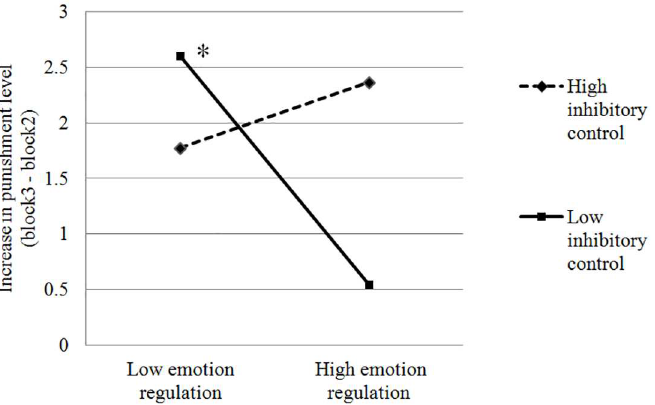
Fig 1. Interactive effect of emotion regulation and inhibitory control on increasein punishment level. a. Predicted values of increase in punishment are plotted 1 standard deviationabove and belowthe mean for NMR [35]. b. The slope for high SSRT (low inhibitorycontrol) is significantly different from zero ( p = .002), and the slope for low SSRT (high inhibitorycontrol) is not, ( p > .33).